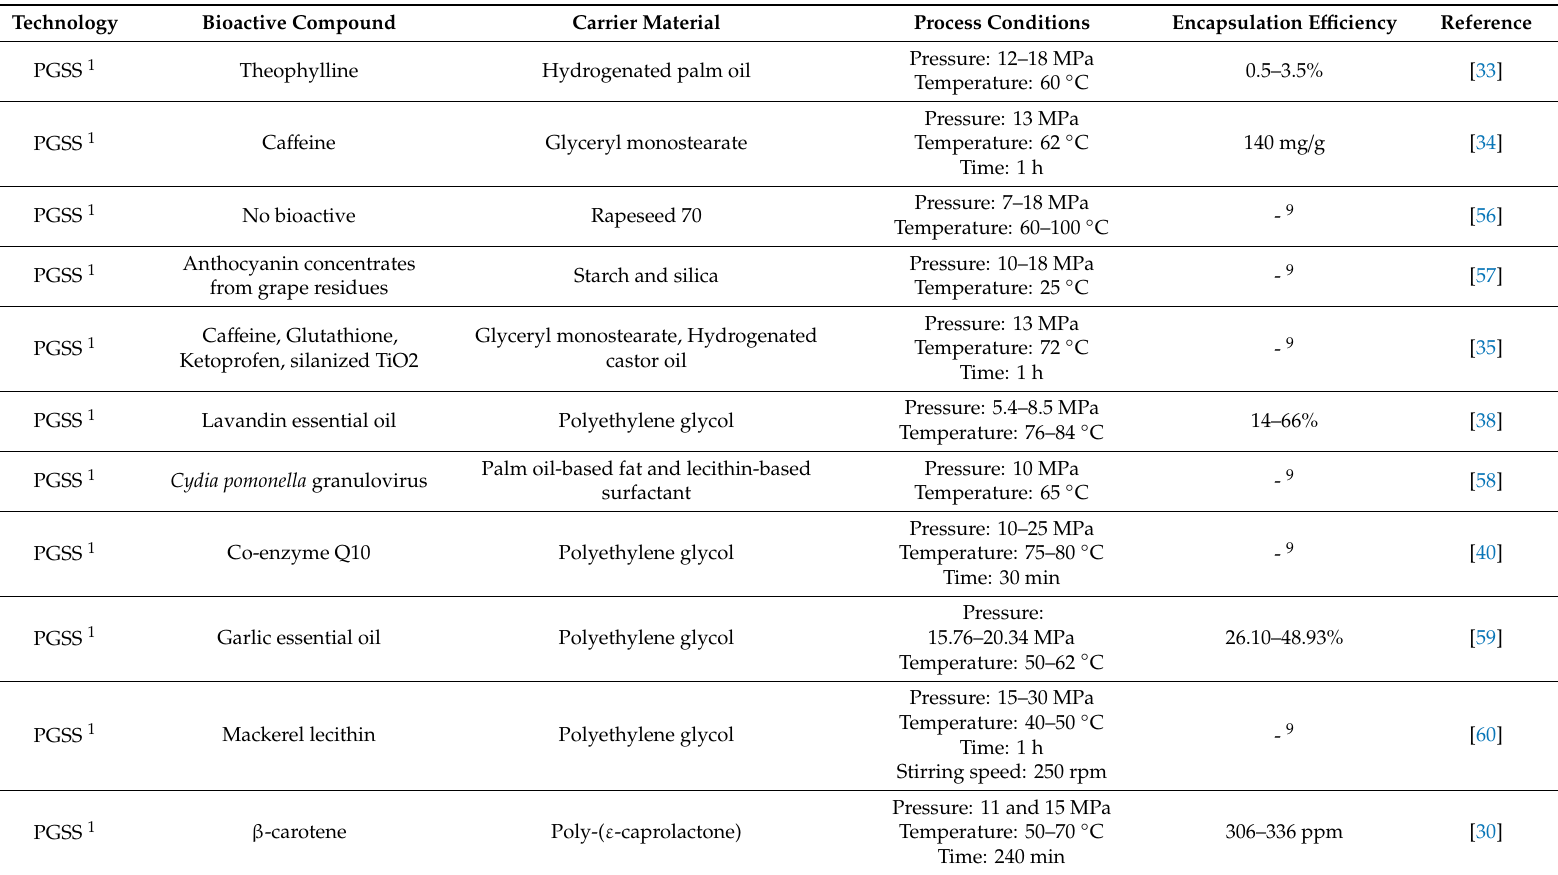
Table 2. Technologies based on supercritical carbon dioxide for the encapsulation of bioactive